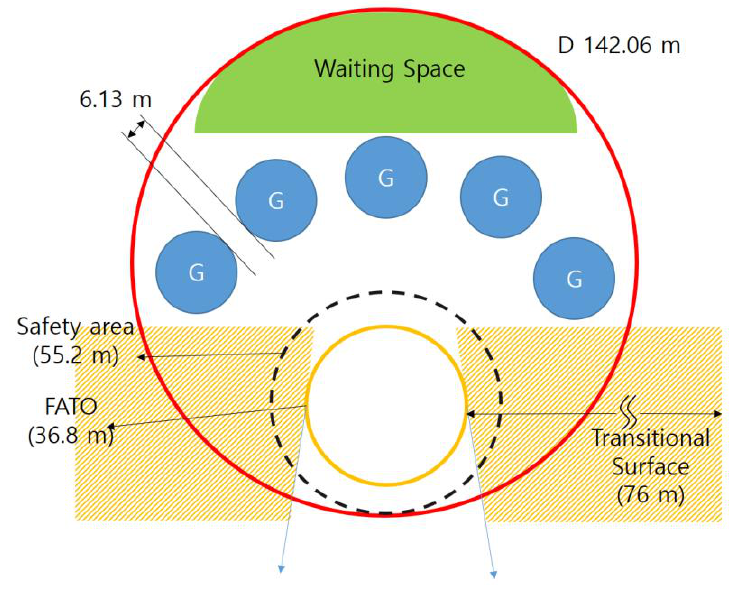
Figure 11. Example of satellite topology that complies with the FAA’s new regulations.